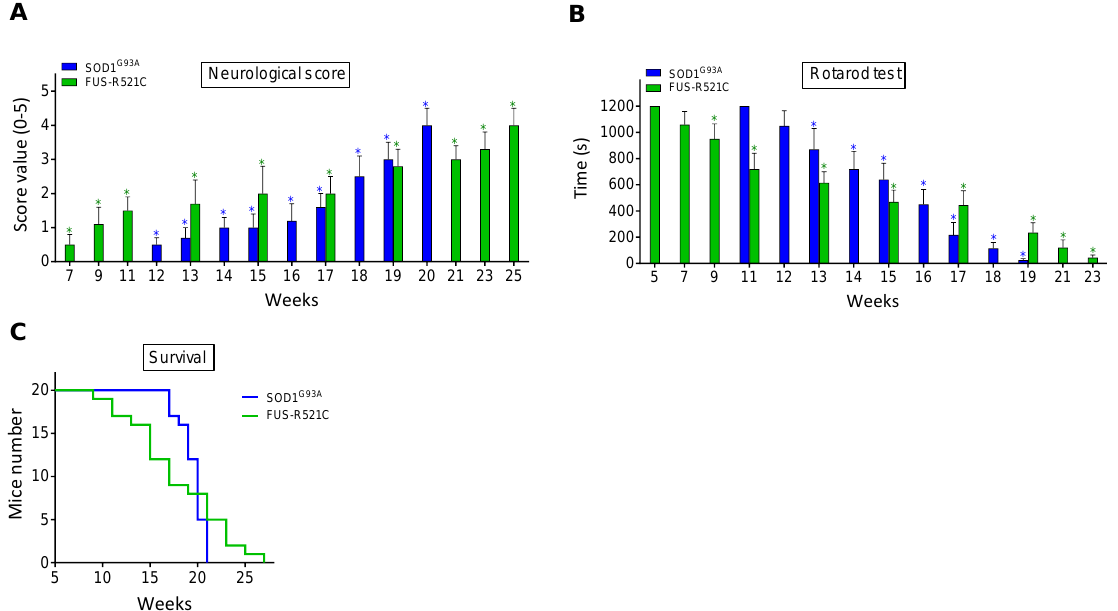
Figure 1. Functional performance and neuromotor coordination in SOD1 G93A and FUS-R521C mice. Neurological score ( A ), rotarod test ( B ) and survival ( C ) were assessed in SOD1 G93A Q and FUS-R521C mice at different times in the progression of the disease. Taking into account the % of animals that died before reaching the advanced progression status, to assess the neurological score and the rotarod test, their number was increased so that n (20 animals) was the same both at onset and at advanced progression. In wild-type controls ( n = 20) the neurological score was equal to 0 and the time for the rotarod test was 1200 s in all cases. Both tests were performed twice a week. On the days of the week on which the animals were not subjected to tests, they were trained in the rotarod for 20 min. Control experiments performed in wild-type mice ( n = 10) rendered a neurological score of 0 and a performance time of 1200 s in the rotarod test in all cases. * p < 0.01 comparing values obtained in amyotrophic lateral sclerosis (ALS) mice versus wild-type controls.